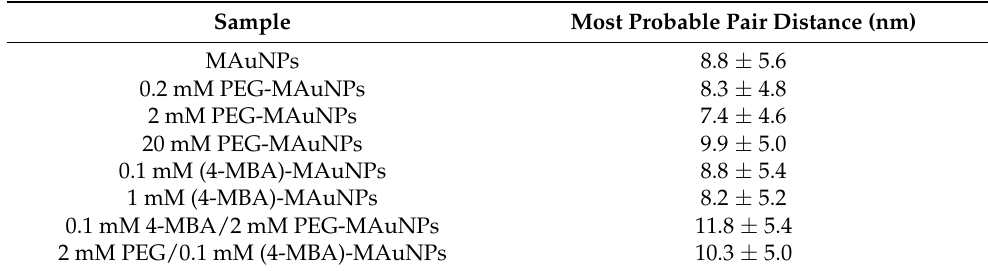
Figure 5. Comparison of raw scattering data of 0.2, 2, and 20 mM PEG-MAuNPs. The arrow depicts the shift in the scattering peak with increasing PEG concentration. Data sets are offset for clarity. Table 1. Most probable pair distance of MAuNPs and various functionalized analogs, as determined by P(r) fits.